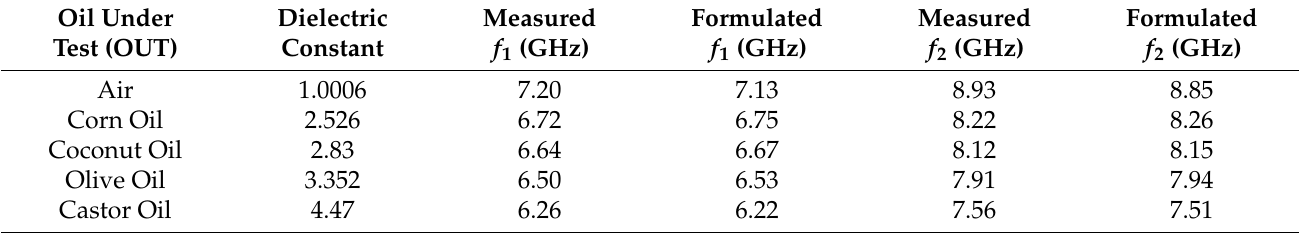
Table 5. Comparison of measured and formulated resonance frequencies of the proposed complementary metaresonator sensor. Oil Under